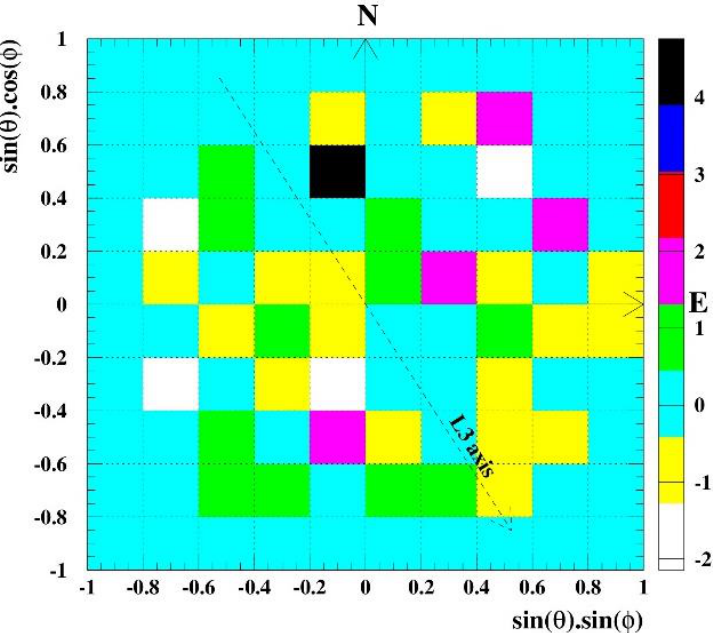
Figure 7. The sigma distribution of 59 sky cells in the 8.39 min live-time bin at 00:07 UT on 9th November 2000.